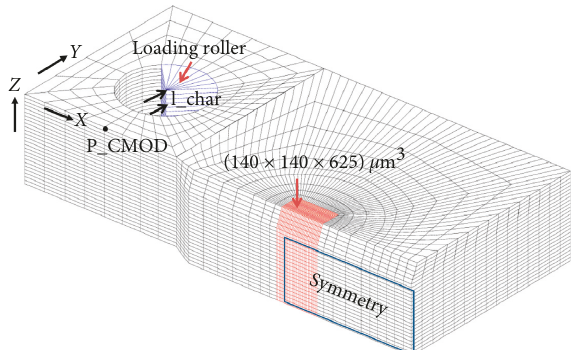
Figure 12: 3D mesh of the quarter of the CTspecimen with loading